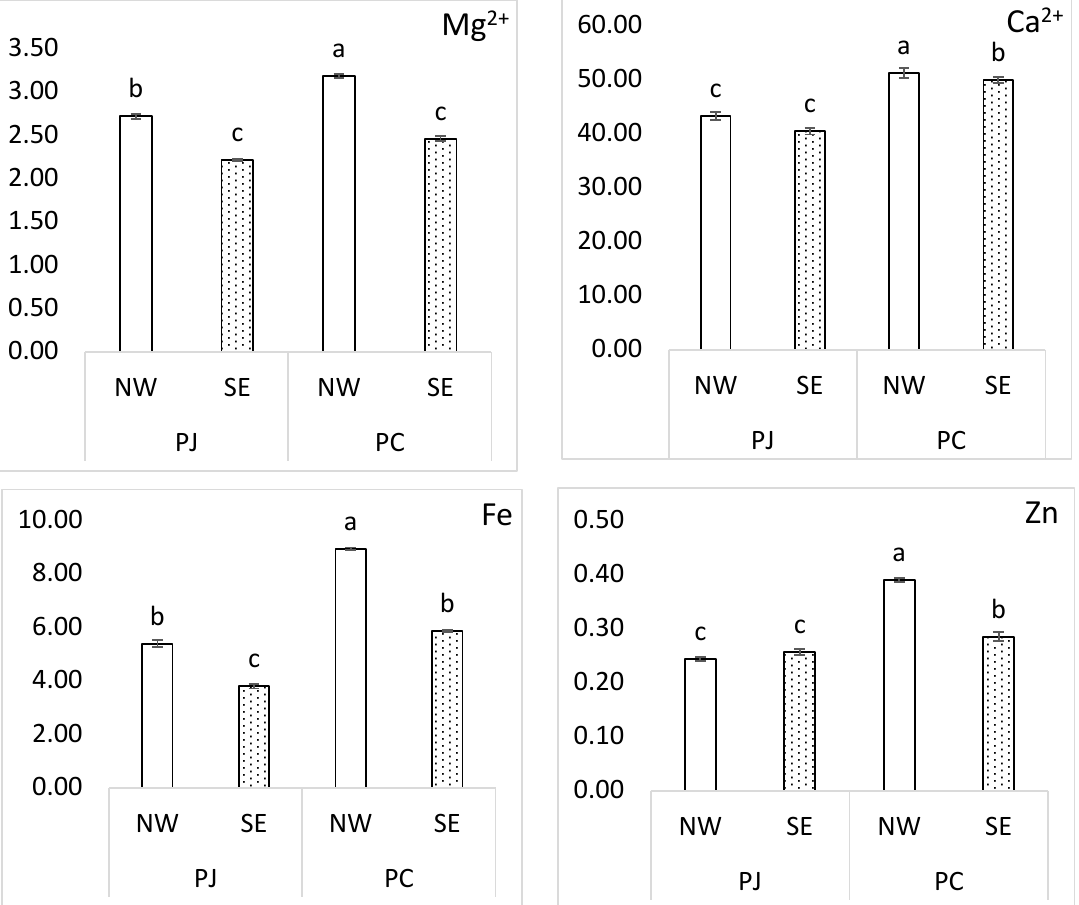
Figure 5. Magnesium (Mg), calcium (Ca), iron (Fe), and zinc (Zn) contents (dry weight basis) of leaves of Prosopis juliflora (PJ) and Prosopis cineraria (PC) from different canopy positions (south east, SE; north west, NW). Every column in each bar represents the mean (±S.E.) of the three replicates. Means with the same letters with a species indicates insignificant differences between the two canopy positions at p > 0.05 according to Duncan Multiple range test. Table 5. Different elemental concentrations in leaves of Prosopis juliflora (PJ) and Prosopis cineraria (PC) at different canopy position (south east and north west).